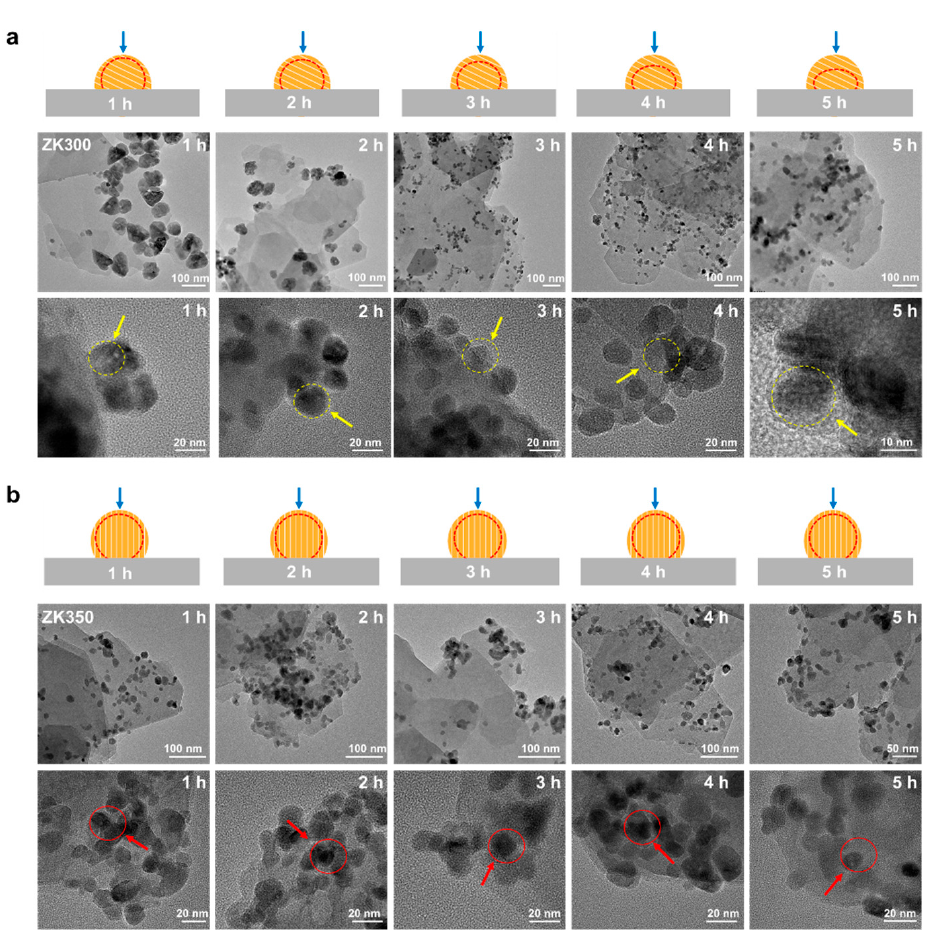
Figure 3. HRTEM images of ( a ) ZK300 and ( b ) ZK350 after dissolution at 1 h, 2 h, 3 h, 4 h, and 5 h, respectively.